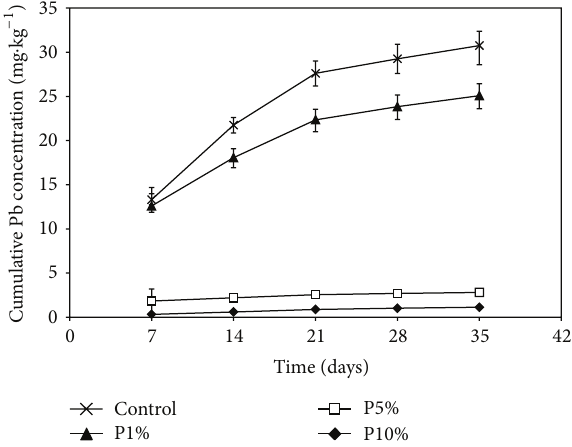
Figure 6: Cumulative Pb concentration in pore water leached from Pb-contaminated soils amended with peat moss according to time through the microcosm test (Control: Pb-contaminated soil without peat moss, P1%: Pb-contaminated soil with 1% peat moss, P5%: Pb- contaminated soil with 5% peat moss, and P10%: Pb-contaminated soil with 10% peat